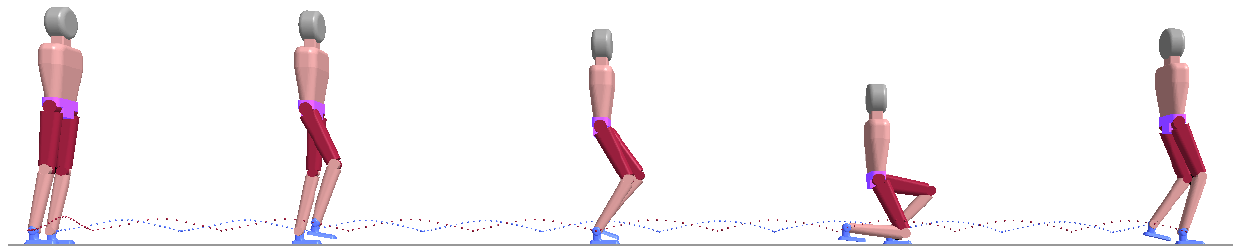
Figure 10. Some robot gaits with different levels of lowering of the center of mass.